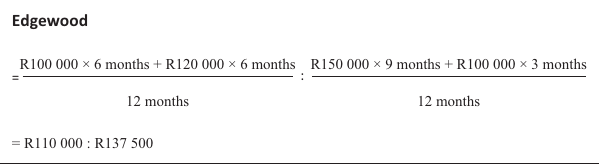
FIGURE 8: Average capital balance ratio in months.